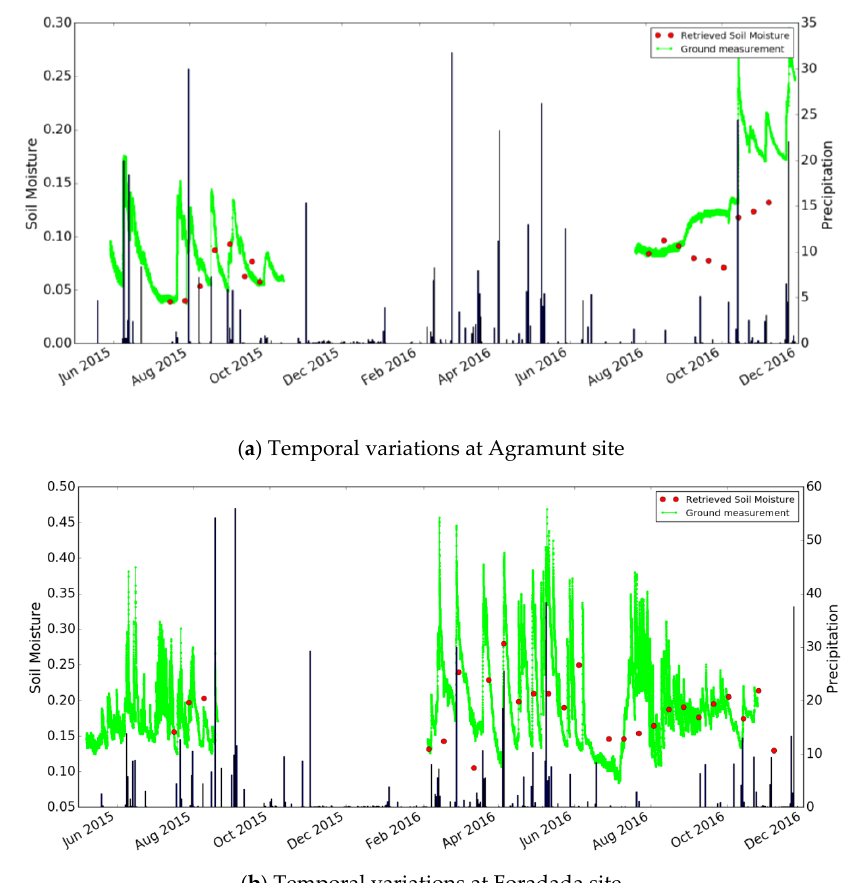
Figure 11. Temporal variations in ground measurements and S1 estimations of soil moisture at the Agramunt site ( a ) and Foradada site ( b ), determined using method 2.